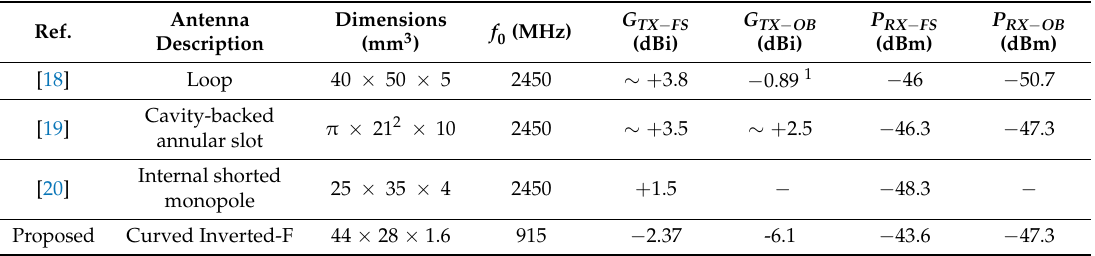
Table 9. Summary of the link budget calculation considering the proposed antenna and antennas demonstrated in the